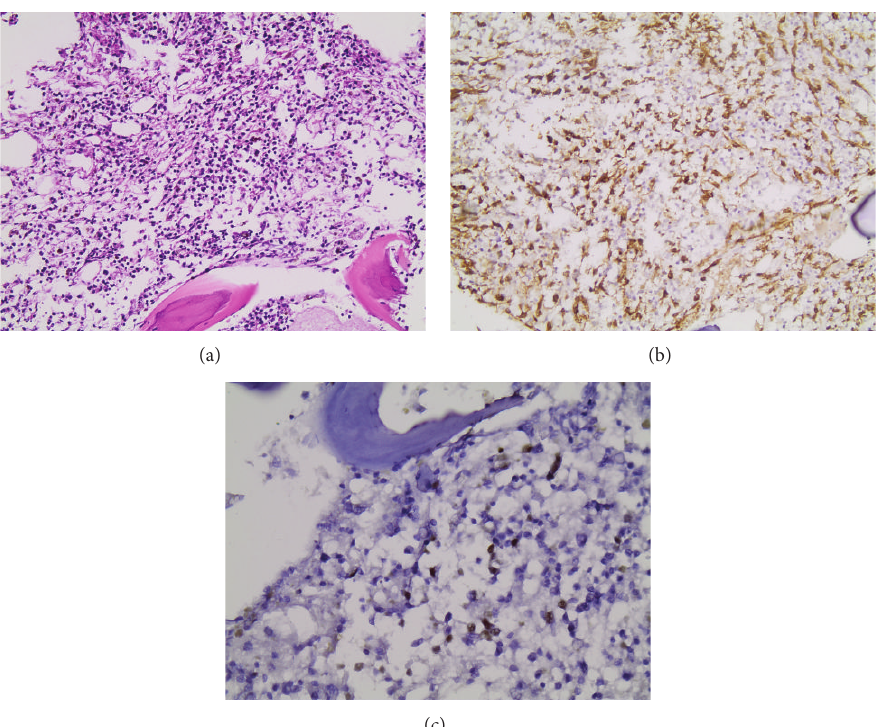
Figure 2: Bone marrow trephine biopsy after induction with an extensive infiltration by spindle shaped mast cells as illustrated in H&E stain (a) as well as c-KIT immunostaining (b). Immunohistochemical expression for TDT also revealed the presence of infiltration by TDT (+) lymphoblasts (c), which however was lower than that observed initially.